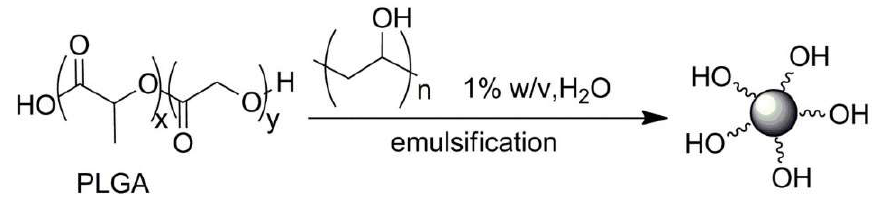
Scheme 29. Schematic illustration of PLGA particles with hydroxyl groups.